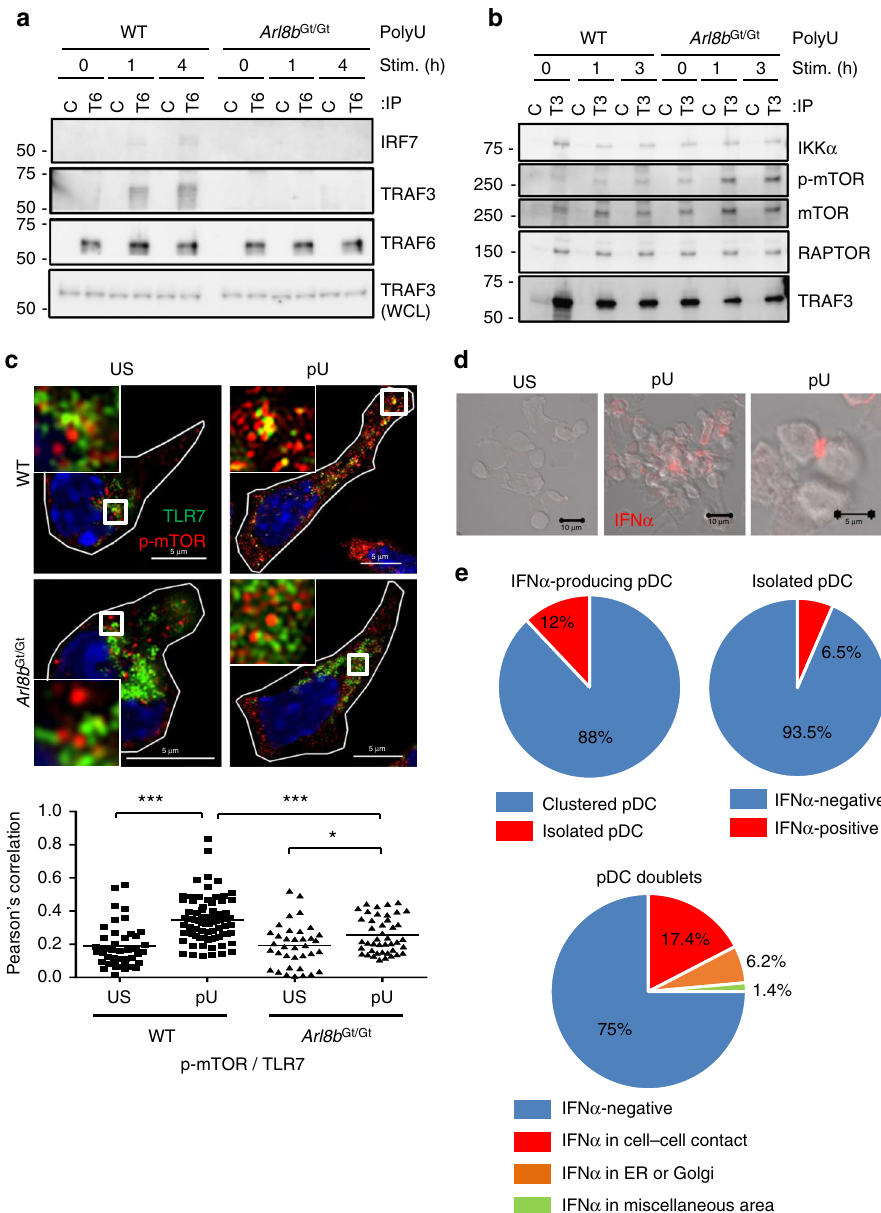
Fig. 6 TLR7 traf fi cking induces TRAF6 – TRAF3 association and IFN- α production in pDC clusters. a , b WT or Arl8b Gt/Gt BM-pDCs were stimulated with 25 μ g/mL polyU for the indicated times prior to lysis and immunoprecipitation using Ab against TRAF6 (T6) or goat IgG negative control (C) followed by immunostaining of the indicated signaling molecules. Apparent molecular mass is indicated (left). Immunostaining of TRAF3 in whole-cell lysate is also shown in the lowermost panel ( a ). Immunoprecipitation of the same cell lysates as in a but using Ab against TRAF3 (T3) or rabbit IgG negative control (C) prior to immunostaining ( b ). c WT and Arl8b Gt/Gt BM-pDCs were either left unstimulated (US) or stimulated with 25 μ g/mL polyU (pU) for 3 h. Cells were then stained with Abs against TLR7 and phosphorylated mTOR (p-mTOR) as indicated. Nuclei were stained with DAPI. Higher magni fi cation images of boxed regions are shown in the insets. Statistical determination of TLR7 co-localization with p-mTOR is shown in the panel below ( n > 24). *** P < 0.001, * P < 0.05 (unpaired two-tailed t -test). Scale bar, 5 μ m. d , e WT BM-pDCs were either left unstimulated (US) or activated (pU) with 25 μ g/mL polyU for 6 – 10 h. Cells were stained with an Ab against Interferon α (IFN α ). Scale bar, 10 μ m (left and middle), 5 μ m (right). In IFN- α -producing pDCs, the percentages of clustered and isolated pDCs were determined ( n = 324). Also, in isolated pDCs, the percentages of IFN- α -positive and -negative pDCs were determined ( n = 600). In pDC doublets, the percentages of pDCs with IFN- α in the cell – cell contact, ER/Golgi, or miscellaneous area are shown ( n =